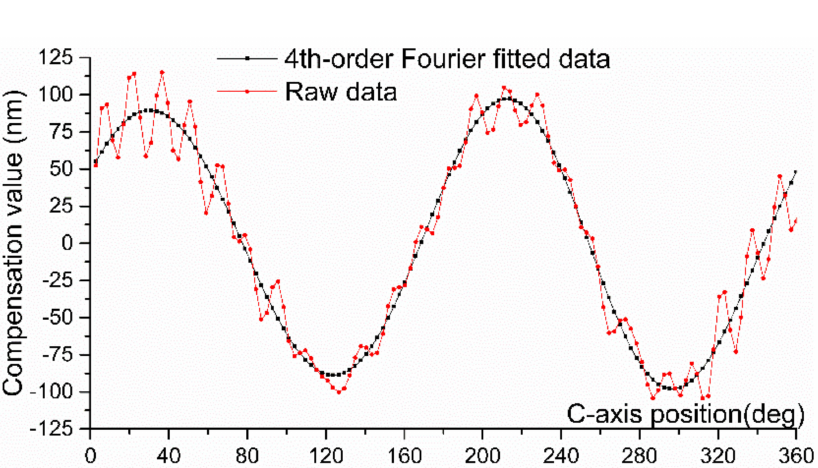
Figure 10. The fitted curve of the WRE compensation data.